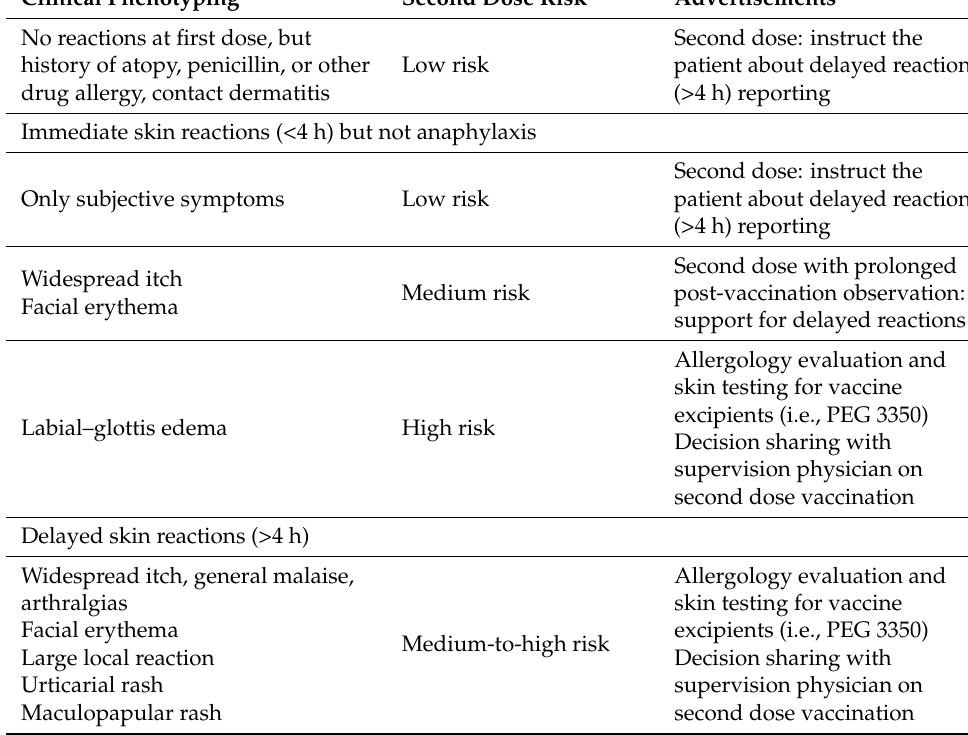
Table 2. Post-vaccinated dose one reactions and second dose risk assessment. Clinical Phenotyping Second Dose Risk